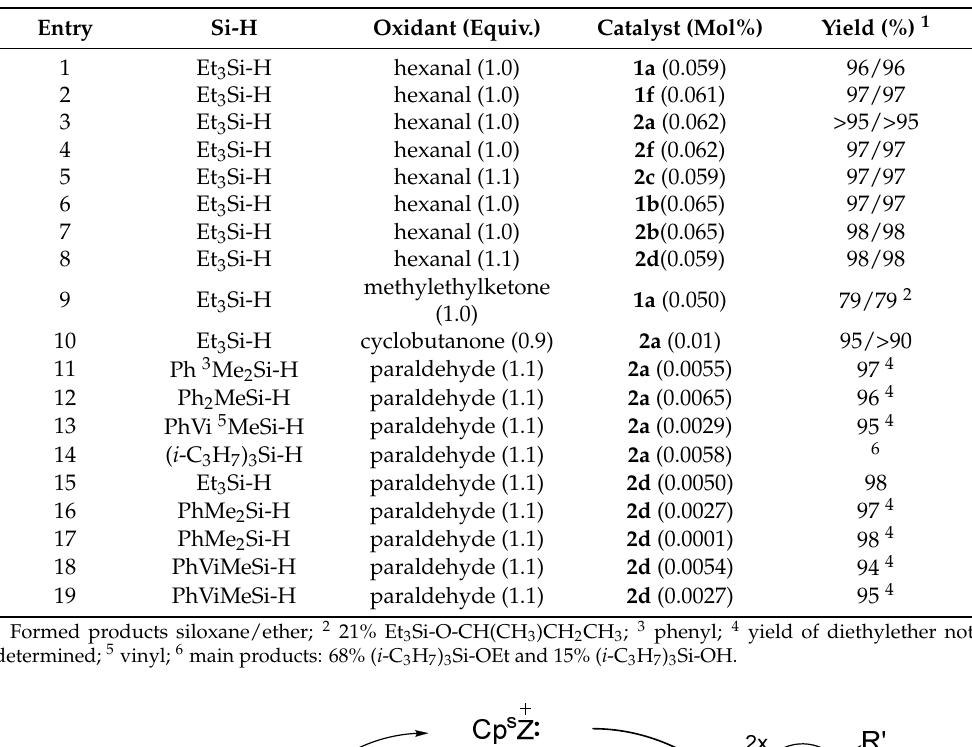
Table 5. Oxidative coupling of hydridosil(ox)anes (Si-H) by aldehydes and ketones (C=O) and simultaneous reductive coupling to ethers in the presence of catalysts 1 and 2 [30]. Entries 1–9 performed at room temperature, entries 10–19 at 50 ◦ C. Entry Si-H Oxidant (Equiv.) Catalyst (Mol%) Yield (%) 1 1 Et 3 Si-H hexanal (1.0) 1a (0.059) 96/96 Et 3 Si-H hexanal (1.0) 1f (0.061) Et 3 Si-H hexanal (1.0) Et 3 Si-H